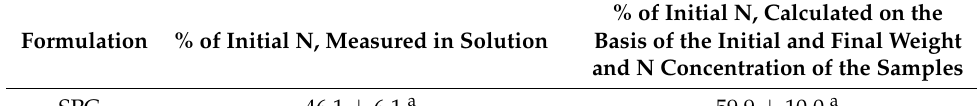
Table 7. N mass balance (comparison of % total N in solution measured by mineralization and Kjeldahl analysis, and % total N in the solid samples measured by elemental analysis) 1 .